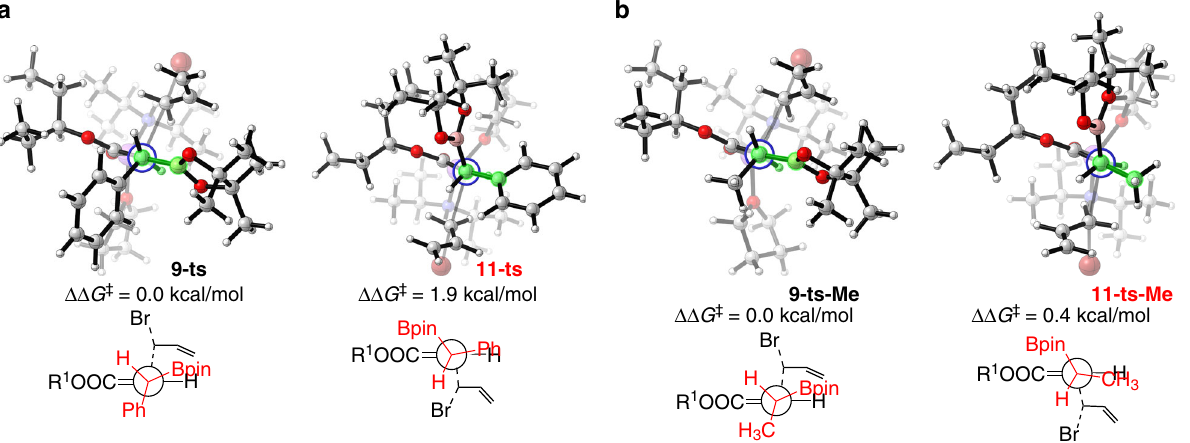
Fig. 4 Optimized structures at nucleophilic substitution steps. a Transition state of 9-ts and 11-ts . b Transition state of 9-ts-Me and 11-ts-Me . (R 1 =